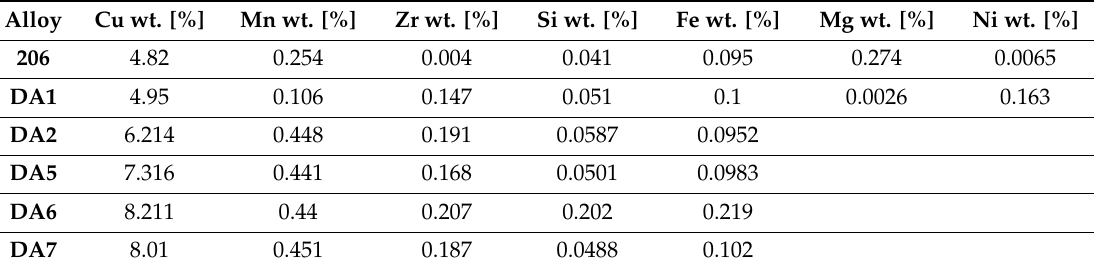
Table 1. Nominal non-grain-refined alloy